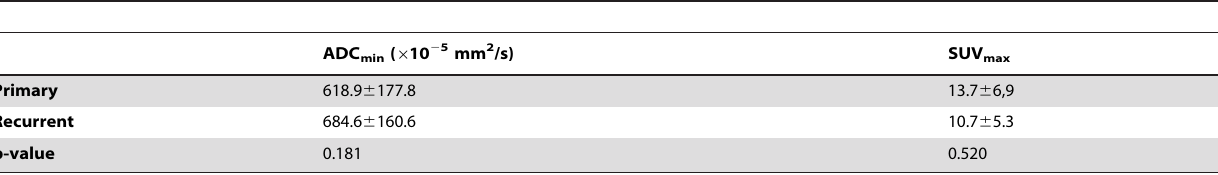
Table 2. Correlations of ADC min and SUV max of primary and recurrent cancer lesions, demonstrating a tendency of higher ADC min and lower SUV max values for recurrent cancers.